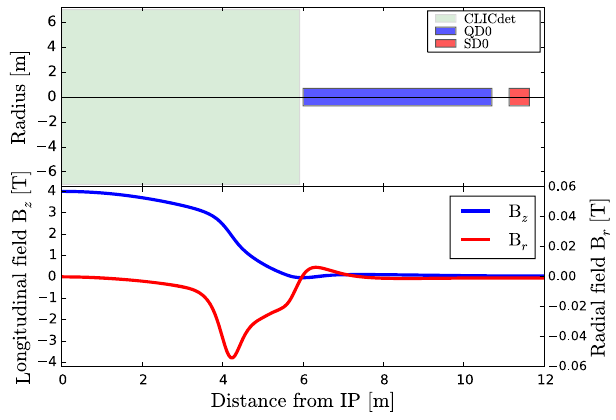
FIG. 4. Schematic overview of the new detector (CLICdet) interaction region layout from the last 12 m of the FFS (upper plot). Simulation of the longitudinal and radial fields (bottom plot). No overlappingbetweenQD0andthenewdetectorfieldwith L (cid:1) ¼ 6 m.